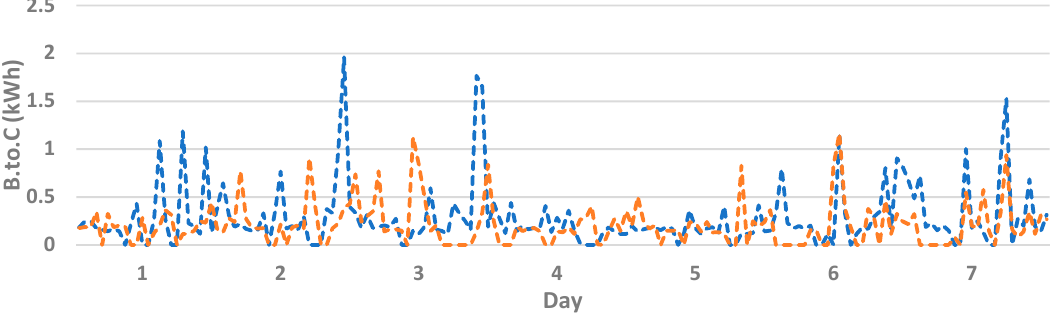
Figure 7. Energy transmission from the battery bank to loads, for a single dwelling. Comparison between the most and least probable scenarios (blue and orange) for one week of April. Source: self-elaboration.